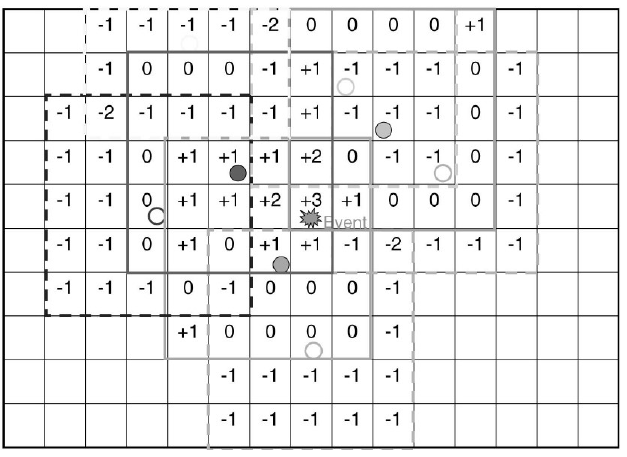
Figure 8. Subtract on Negative Add on Positive (SNAP) reproduced with permission from Michaelides, SNAP: Fault Tolerant Event Location Estimation in Sensor Networks Using Binary Data; published by IEEE,